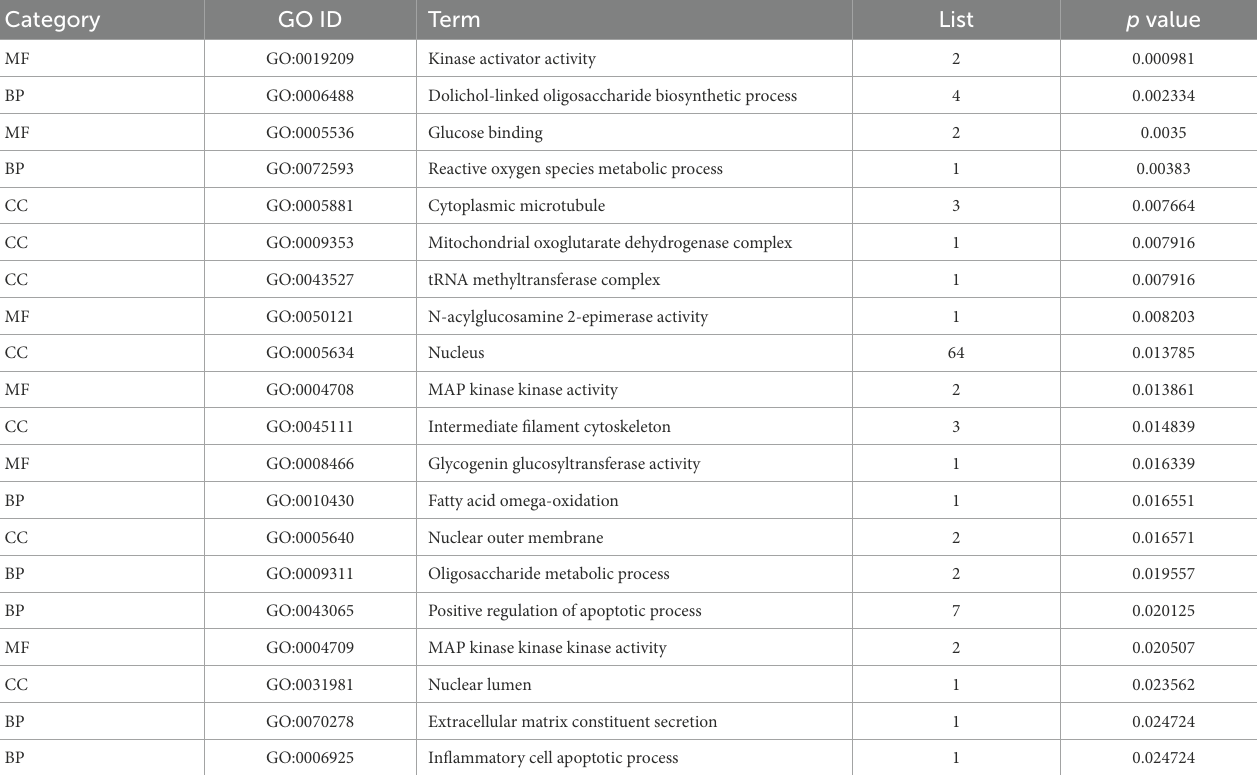
TABLE 3 Top 20 significant GO terms of the overlapped DEGs in livers.